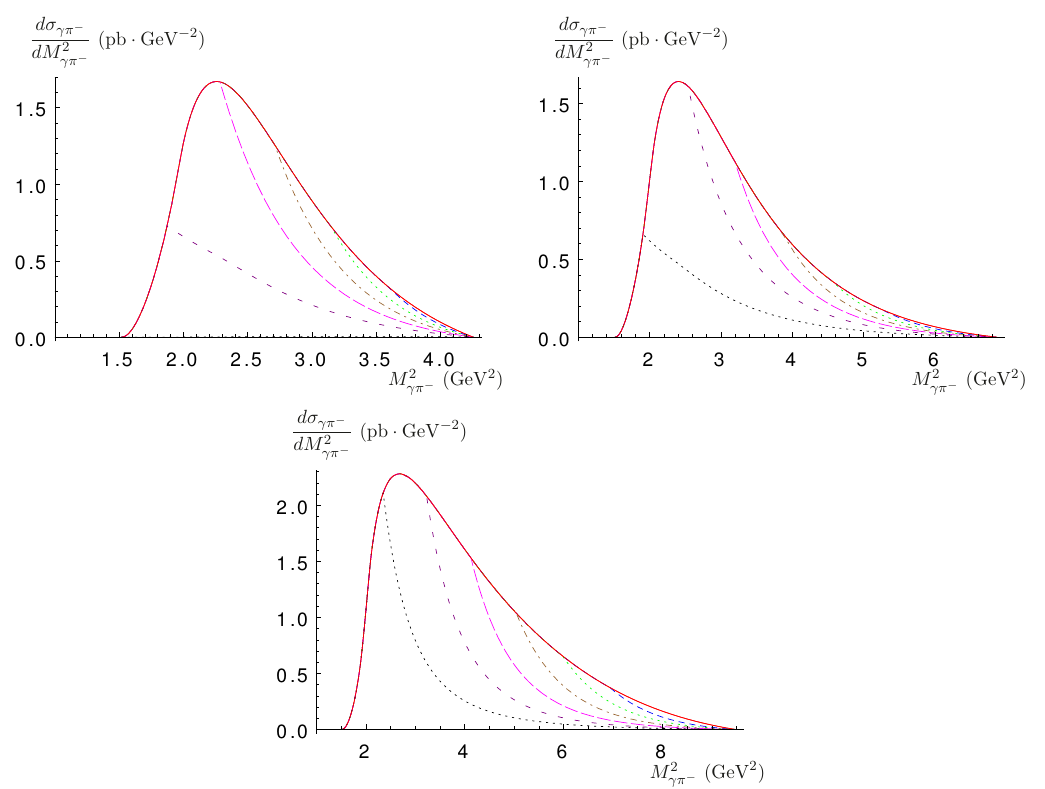
2 Figure 16 . The differential cross section dσ for γπ − pair production on a neutron γπ − /dM γπ − target. Solid red: no angular cut. Other curves show the effect of an upper angular cut θ for the out-going γ : 35 ◦ (dashed blue), 30 ◦ (dotted green), 25 ◦ (dashed-dotted brown), 20 ◦ (long-dashed magenta), 15 ◦ (short-dashed purple) and 10 ◦ (dotted black). Up, left: S γN = 10 GeV 2 . Up, right: S γN = 15 GeV 2 . Down: S γN = 20 GeV 2